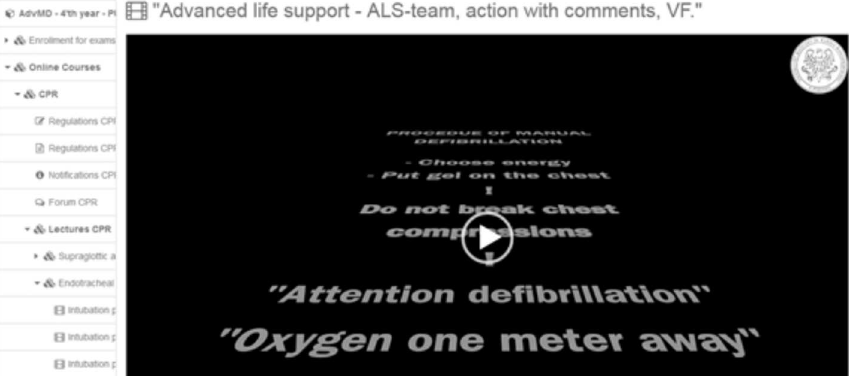
Figure 4. The procedure of defibrillation as text used in the ALS movie – the text layout is the same as in the “Star Wars” movie (it was prepared in this way on purpose so that the students would remember the procedure of defibrillation better)